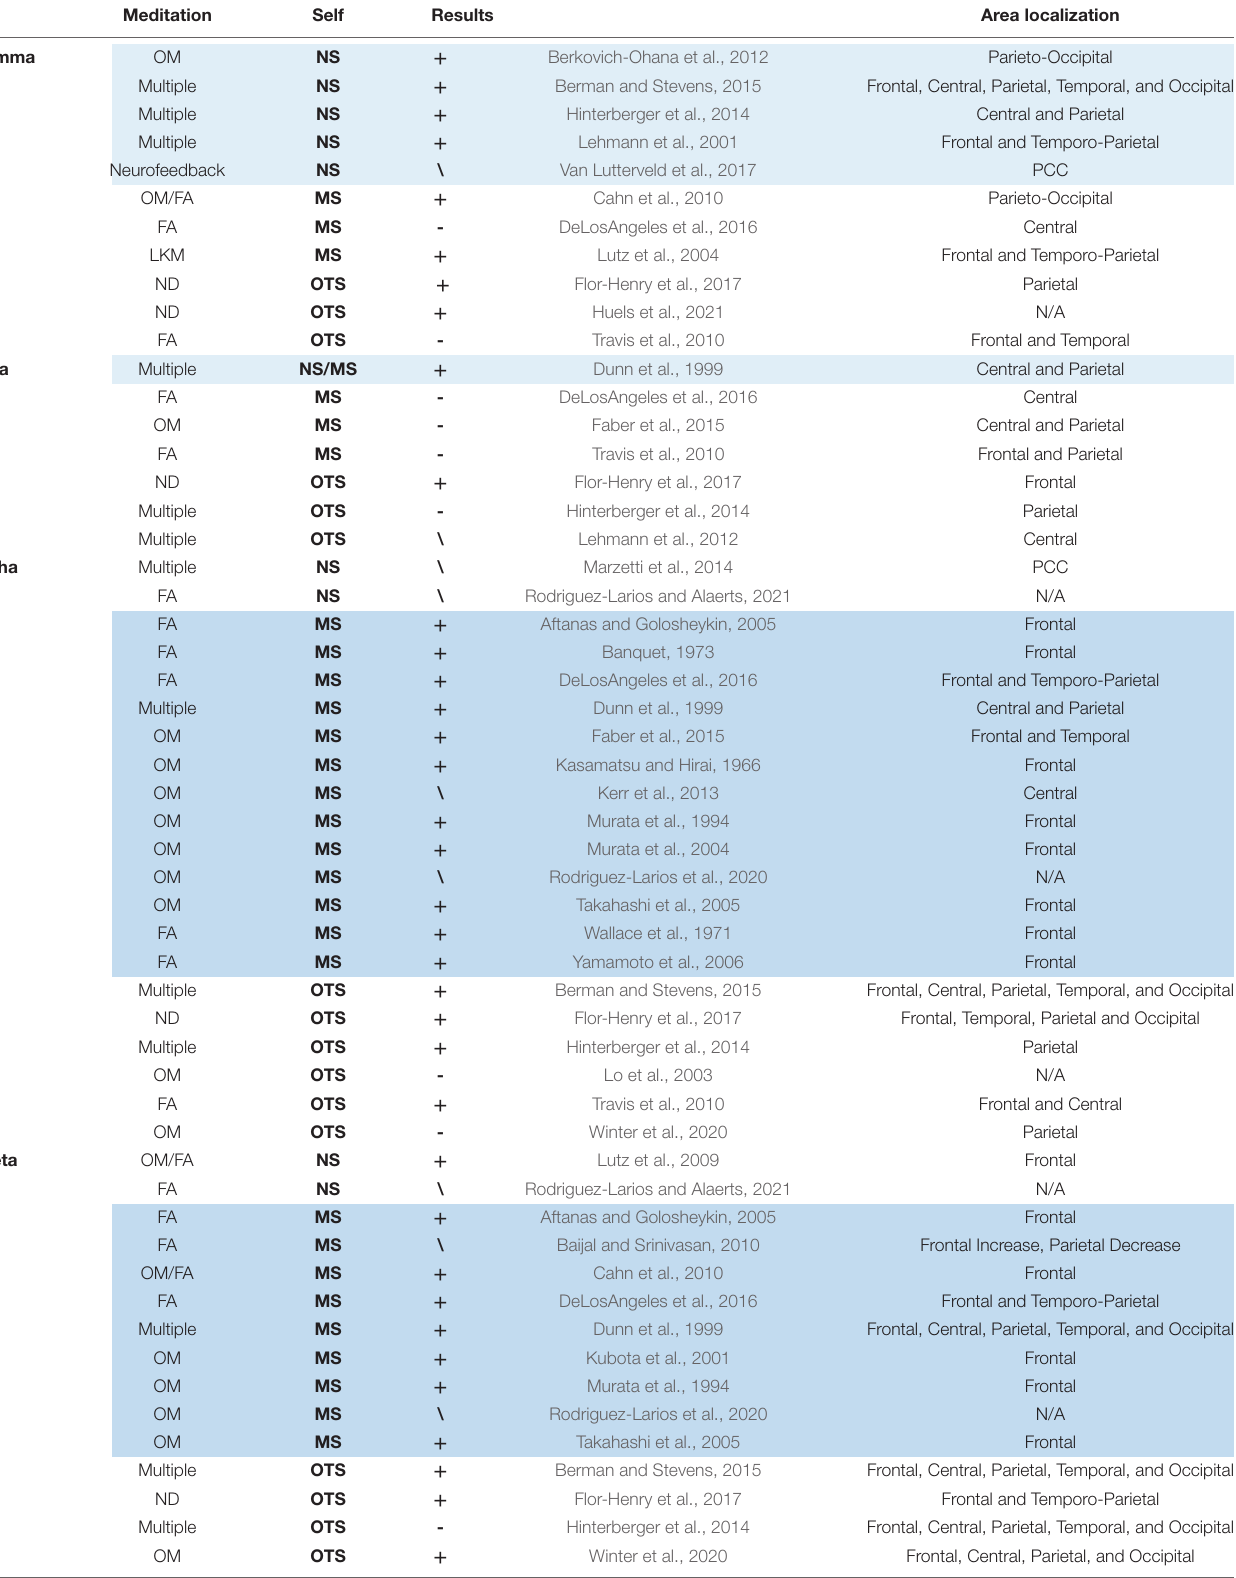
TABLE 4 | Summary of main studies and their localization.